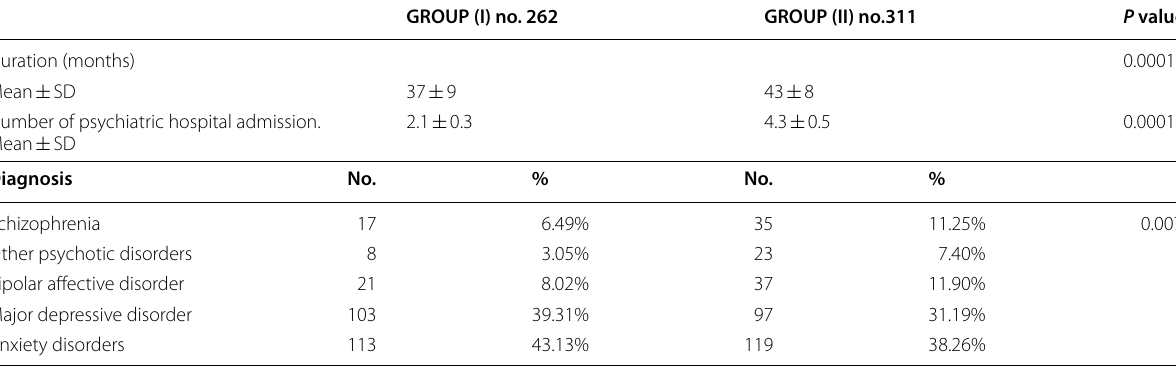
P value < 0.05 is considered statistically significant (*). P value < 0.001 is considered highly significant